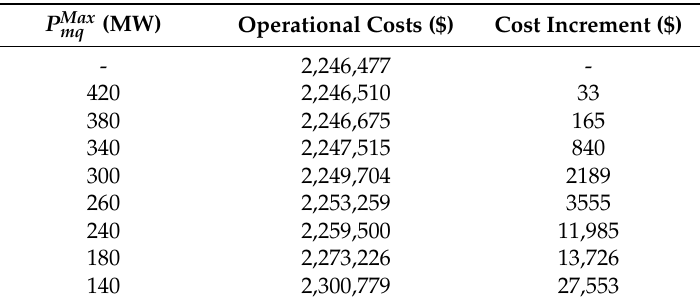
Table 5. Impact of congestion on operating